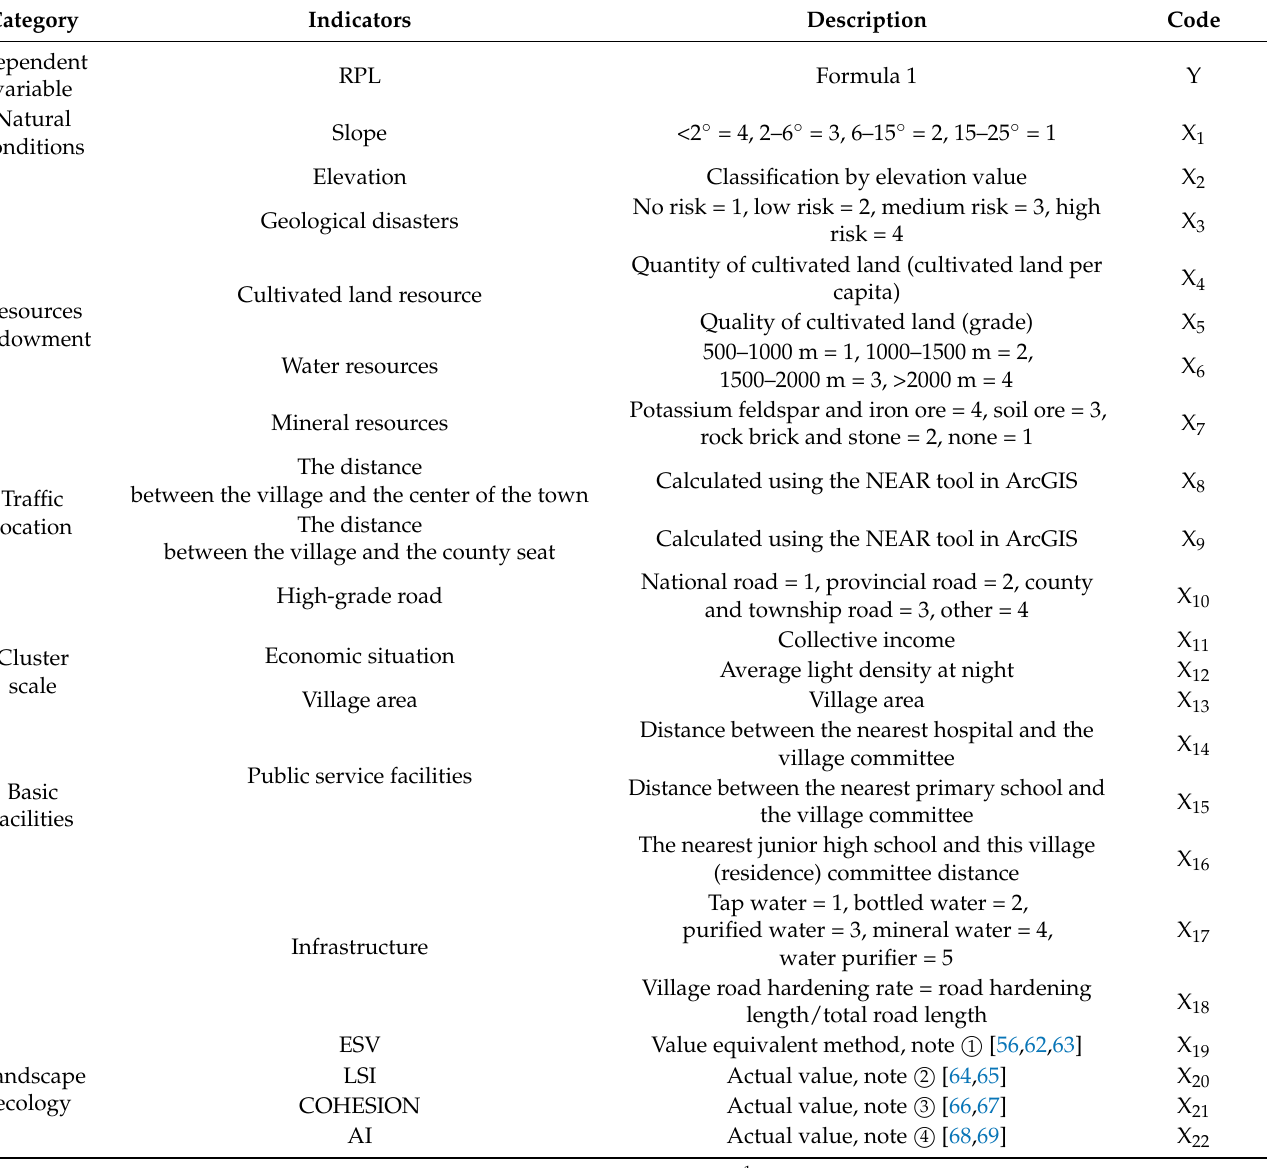
Table 2. Index system of